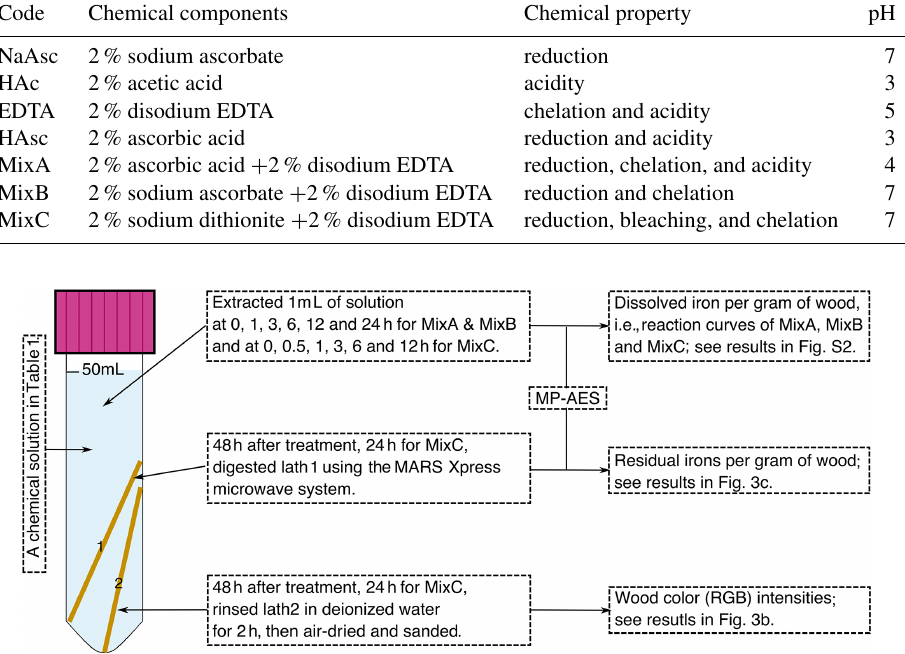
Figure 2. Diagram of one chemical destaining experiment for one pair of wood laths from the same subfossil tree in a Falcon ® 50mL tube. MP-AES: microwave plasma atomic emission spectrometer, Agilent